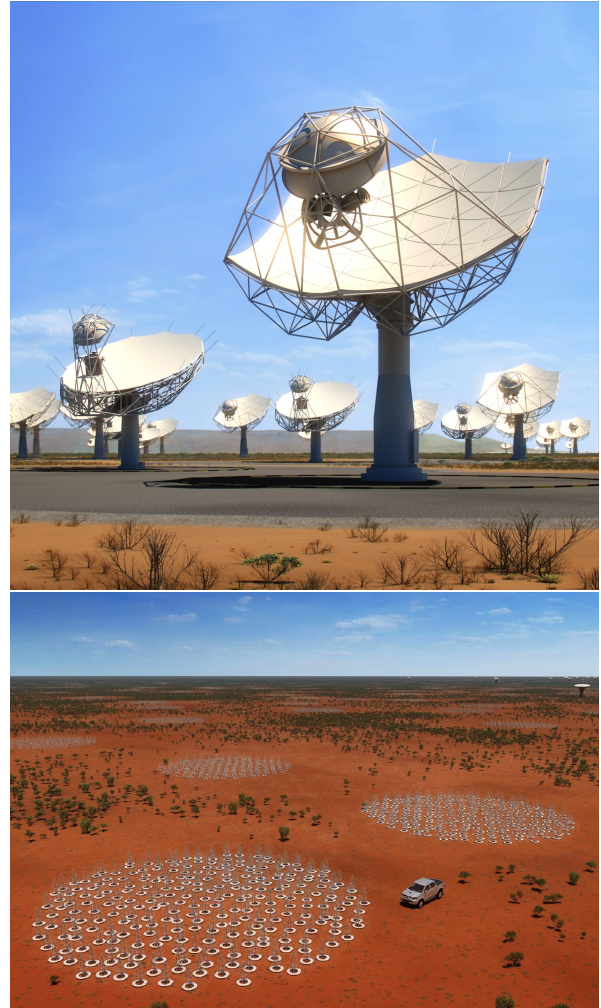
Figure 1. ( Top ) The dishes for SKA-Mid, located in South Africa, will generate 62 exabytes of raw data per year, which is enough to fill 340,000 average laptops with content every day. ( Bottom ) The aperture arrays for SKA-Low, located in Australia, will generate five zettabytes of data per year. Unlike conventional dishes, the “beam” of these antennas is formed electronically, allowing each station to look at multiple regions of the sky simultaneously. The total field of view is essentially limited by the signal processing capacity. Image credits: SKA